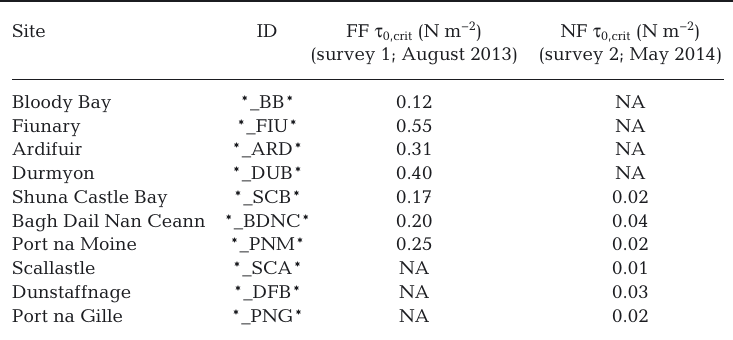
Table 2. Summary of erosion measurements from far-field (FF) and near- field (NF) surveys, including critical erosion threshold τ 0,crit (N m −2 ) NA: not